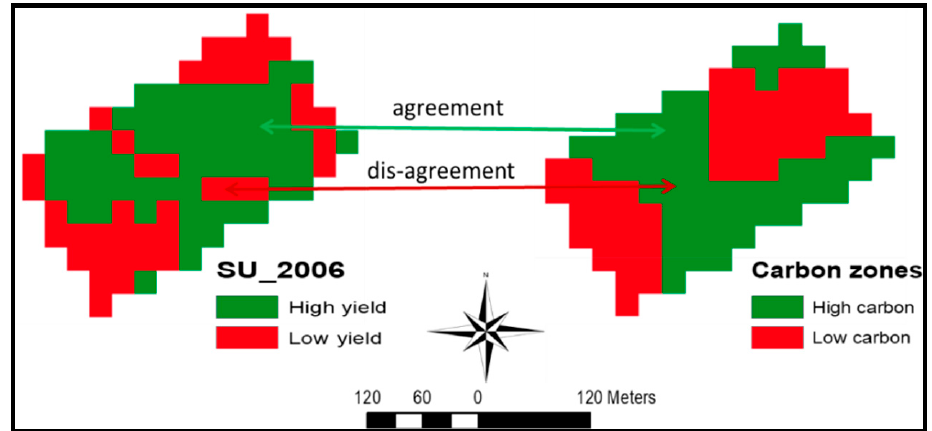
Figure 2. Example of pixel agreement for the calculation of pixel similarity.